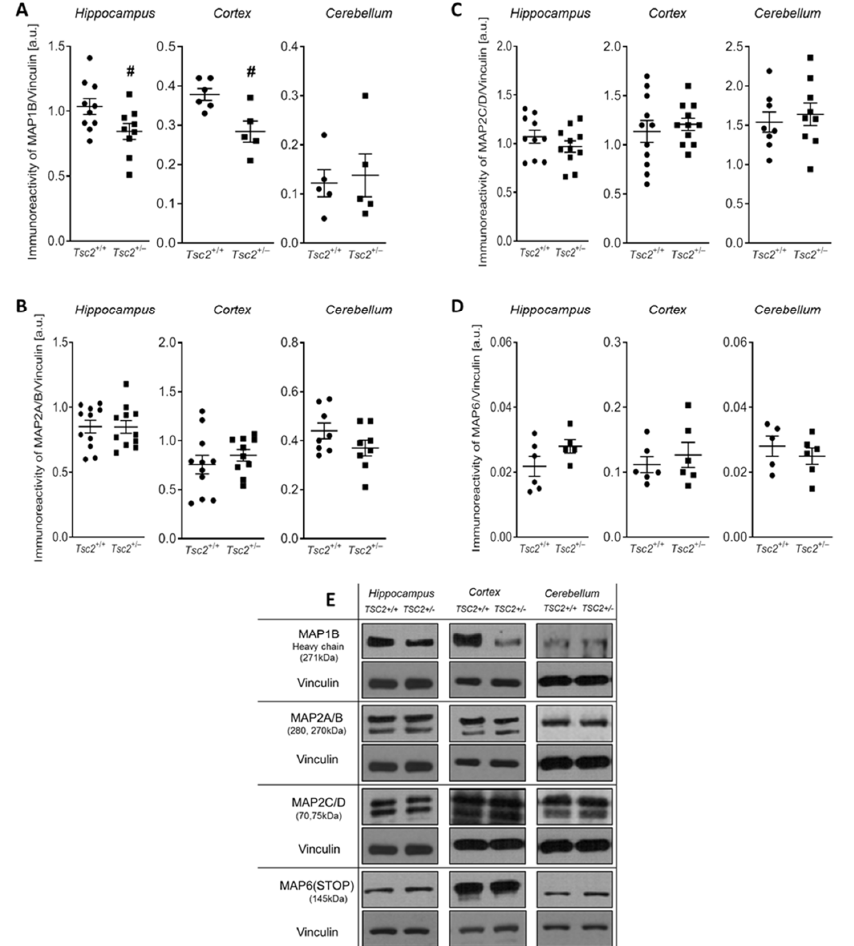
Figure 4. The effect of Tsc2 haploinsufficiency on the protein level of the MAP1B, MAP2A/B, MAP2C/D, and MAP6 (STOP) in the mouse brain. The immunoreactivity of proteins in control and Tsc2 +/ − mice was determined by using Western blot analysis. Densitometric analysis of MAP1B ( A ), MAP2A/B ( B ), MAP2C/D ( C ), and MAP6 (STOP) ( D ) and representative pictures ( E ) in the hippocampus, cerebral cortex, and cerebellum were shown. The results of the densitometric analysis were normalized to Vinculin levels. Data represent the mean values ± SEM from n = (5–10) separate animals for MAP1B, n = (8–11) separate animals for MAP2, and n = (5–6) separate animals for MAP6 (STOP) from three different litters. Data were analysed using Student’s t ‐ test. # p < 0.05, vs. control (wild ‐ type animals).